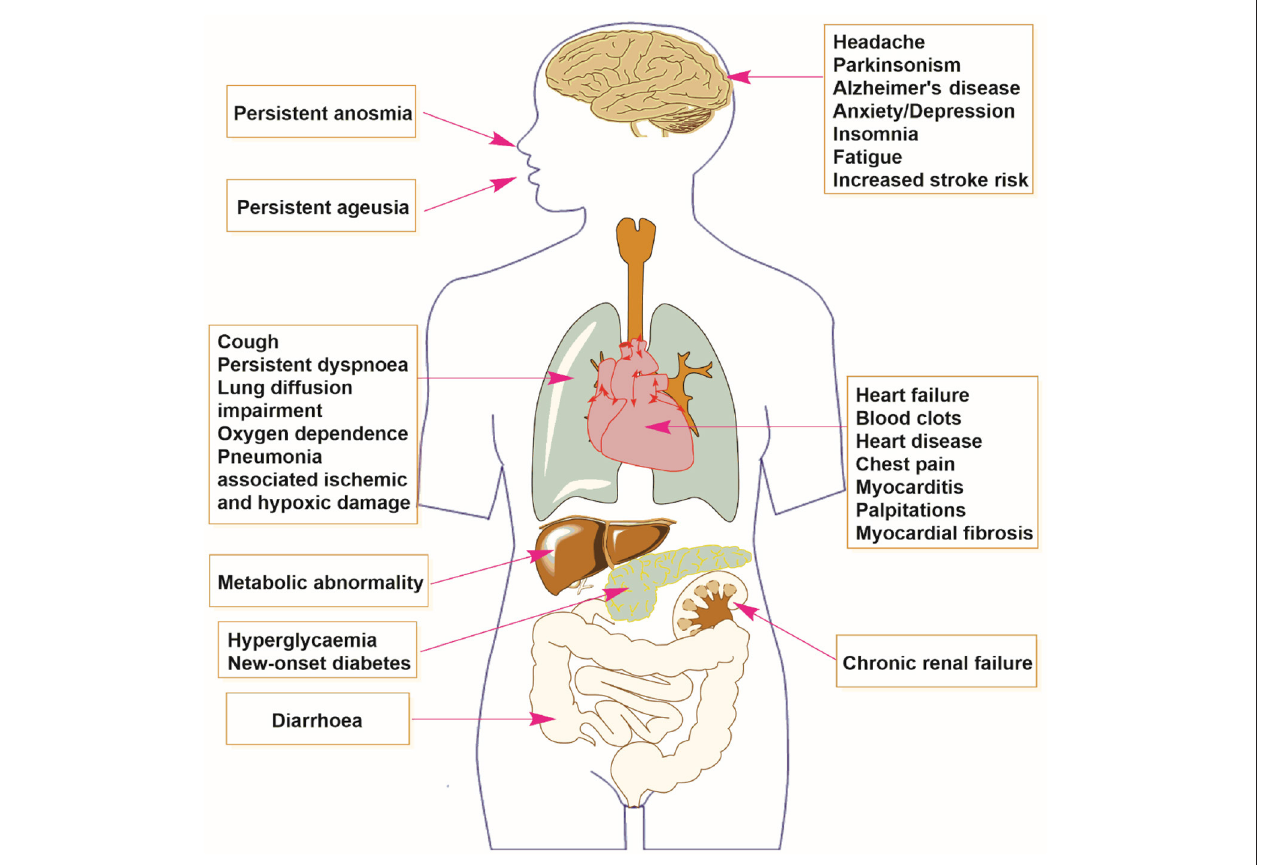
FIGURE 1 | Multiple organ sequelae of SARS-CoV-2